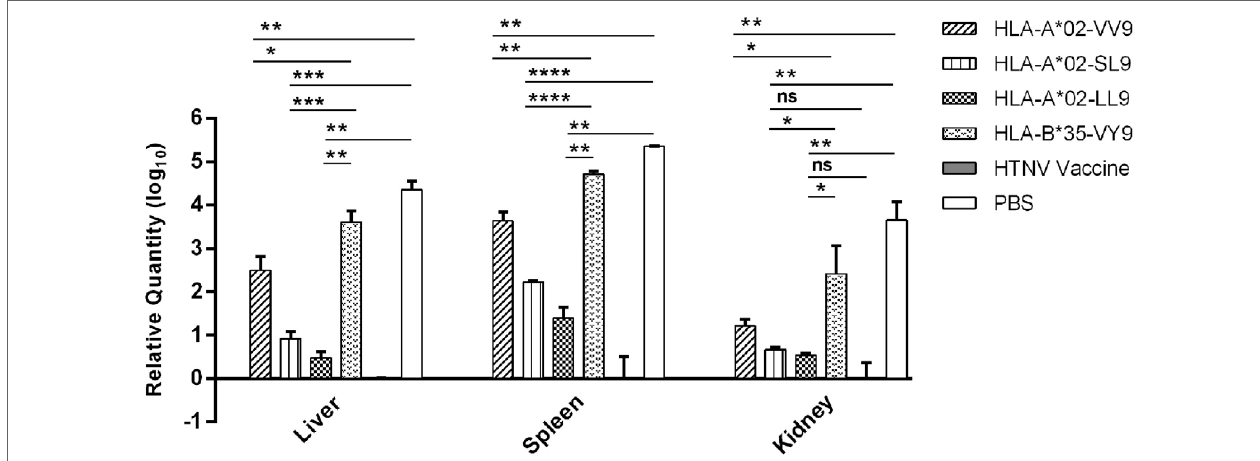
FigUre 5 | Detection of Hantaan virus (HTNV) RNA loads via RT-PCR in the major organs of HTNV-challenged HLA-A2.1/K b transgenic (Tg) mice. The HLA-A2.1/K b Tg mice were divided into six groups ( n = 6 each) according to the different immunizations, including the mice immunized with the HLA-A*02-restricted HTNV glycoprotein epitopes VV9 (VMASLVWPV), SL9 (SLTECPTFL), and LL9 (LIWTGMIDL), the HLA-B*35-restricted HTNV NP epitope VY9 (aa131–aa139, VPILLKALY), the hemorrhagic fever with renal syndrome (HFRS)-inactivated vaccine or PBS. The group immunized with the HLA-B*35-restricted HTNV NP epitope VY9 (unrelated peptide) and PBS served as negative controls. The group immunized with the HFRS vaccine served as the positive control. Ten days after the final immunization booster, the Tg mice were challenged with the HTNV 76-118 strain and sacrificed 4 days after HTNV challenge. The HTNV RNA loads ( y -axis) were detected in the liver, spleen, and kidneys of each immunized group ( x -axis) after HTNV challenge by RT-PCR. The results shown were comparison of the HTNV RNA loads among six immunization groups and recorded as the cycle time ( C t ) and quantified by 2 −∆∆ C t . The Student’s t -test was used for statistical evaluation. p -Values below 0.05 ( p < 0.05) were considered statistically significant. * p < 0.05, ** p < 0.01, *** p < 0.001, **** p < 0.0001, ns indicates no significant